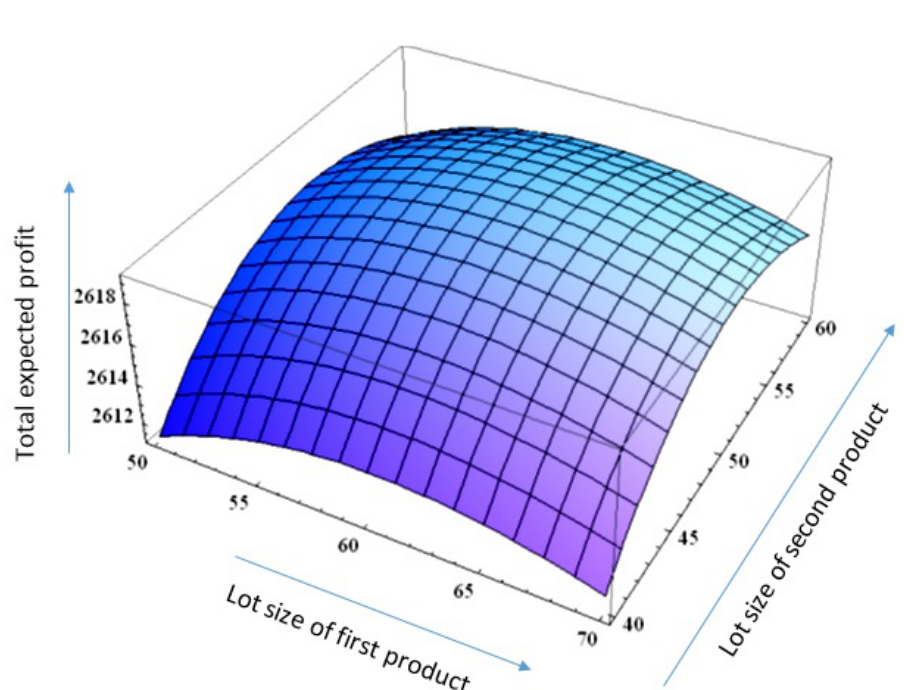
Figure 4. The total expected profit versus lot size of two products ( q 1 , q 2 ) .